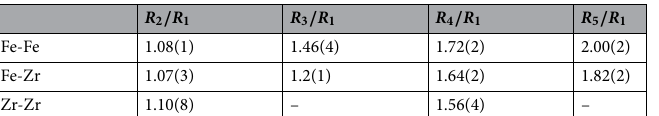
Table 3. Relative peak positions of the i th Gaussian obtained by fitting Eq. (1) to the partial Fe-Fe, Fe-Zr, and Zr-Zr radial distribution functions (RDF) for the simulated amorphous structures of Fe 0.93 Zr 0.07 , Fe 0.90 Zr 0.10 , and Fe 0.80 Zr 0.20 . For Fe-Fe and Fe-Zr, the R 4 and R 5 values are the peak positions of the first and second sub- peaks of the second visible peak of the partial RDFs. Fewer Gaussians are used to fit the Zr-Zr partial RDF and values for R 3 and R 5 are therefore missing so that the R 4 value is the peak position of the second visible peak in the Zr-Zr partial